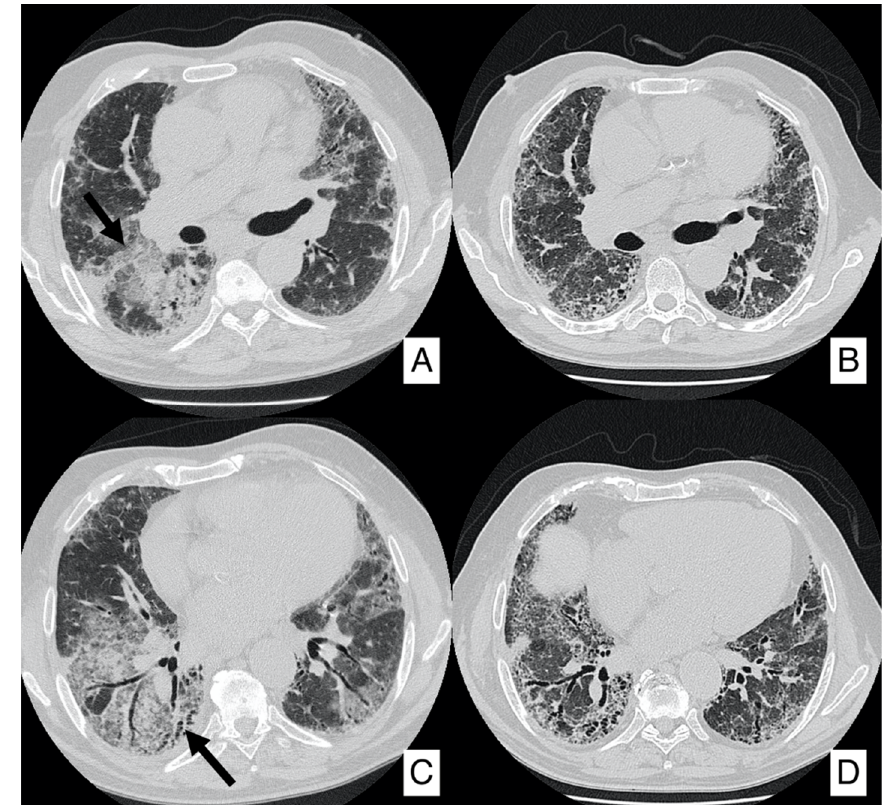
Figure 10. Same IPF patient as Figure 8: comparison between CT acquired during exacerbation ( A , C ) and follow-up scan ( B , D ), the latter performed 4 months later. Images below the carena ( A , B ) demonstrate resolution of ground-glass opacification of the right lung (apical segment of the lower lobe, black arrow); similarly, images acquired at basal levels clearly show that ground-glass attenuation of the lower lobes (black arrow for the right lower lobe) decreased at the follow-up evaluation.